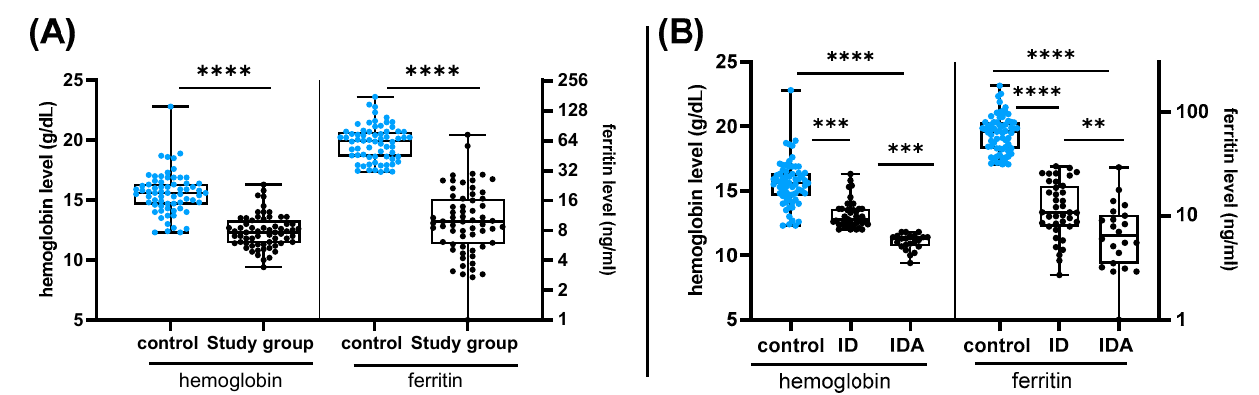
Figure 1. The levels of hemoglobin and ferritin among control and study group. ( A ) Hemoglobin